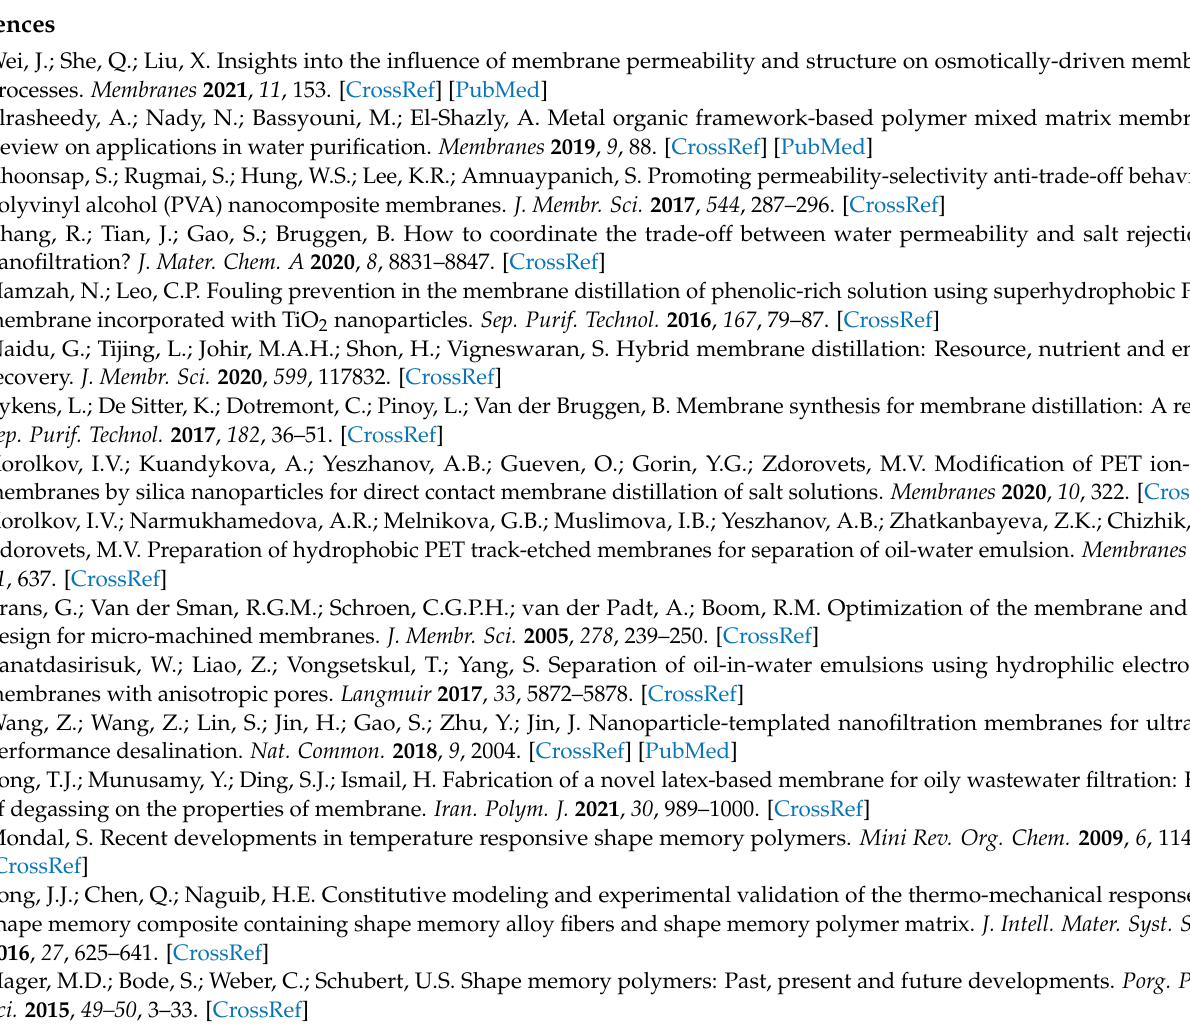
loading of CNTs on PLLA membranes by filtrating CNTs suspension, Figure S2: DMA (Tan δ ) curve of obtained porous PLLA, Figure S3: SEM images of CNTs loaded on PLLA membranes and wrinkled membranes with different draw ratios (1.0 (a), 1.5 (b), 1.7 (c), 2.0 (d)) after recovery of PLLA, Figure S4: SEM images of wrinkled membranes (Draw ratio = 1.7) with different volume (1.5 mL (I), 2.0 mL (II), 2.5 mL (III), 3.0 mL (IV)) after recovery of PLLA, Figure S5: SEM images of wrinkled membranes (Draw ratio = 1.7, Volume = 2.5 mL) with different CNT contents in suspension (0.01 mg mL − 1 (A), 0.015 mg mL − 1 (B), 0.02 mg mL − 1 (C), 0.025 mg mL − 1 (D)) after recovery of PLLA, Figure S6: Image of homemade separation device, Figure S7: SEM images of reference with low (A) and high (B) magnifications, Video S1: Contact angle evolution on reference, Video S2: Contact angle evolution on